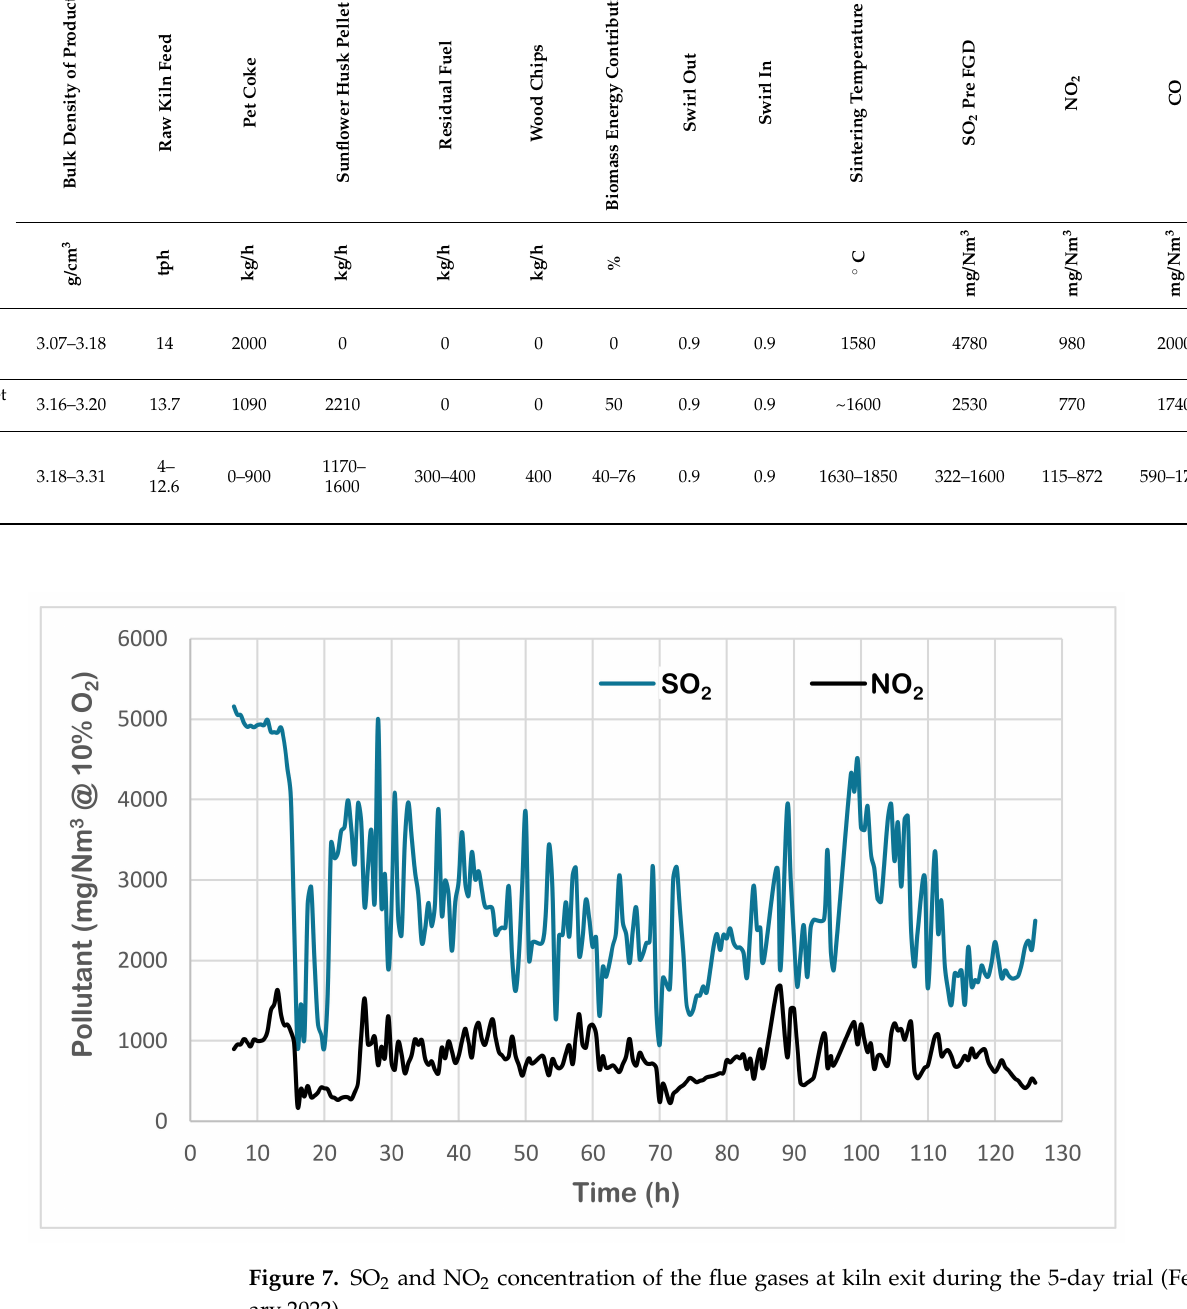
Figure 7. SO 2 and NO 2 concentration of the flue gases at kiln exit during the 5-day trial (Febru- ary